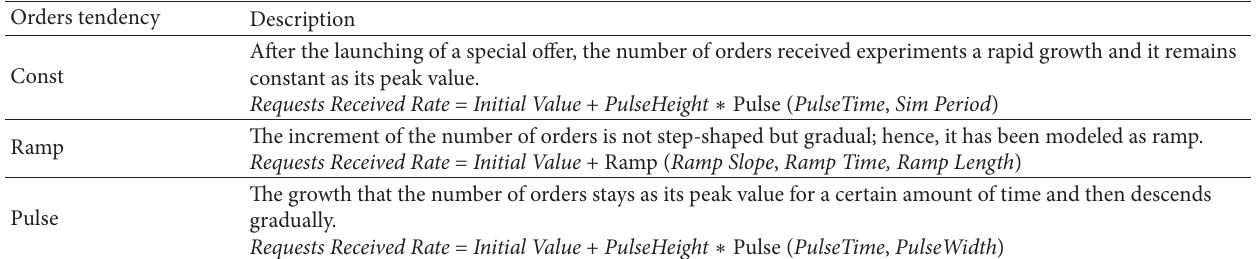
Table 1: Patterns of behavior of customer’s